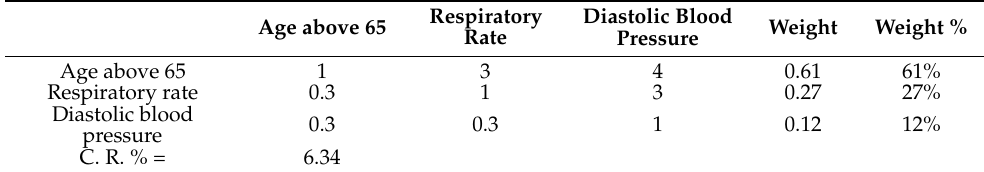
Table 7. Decision matrix and weights computation for Level 3 subcriteria derived from vital signs criteria.